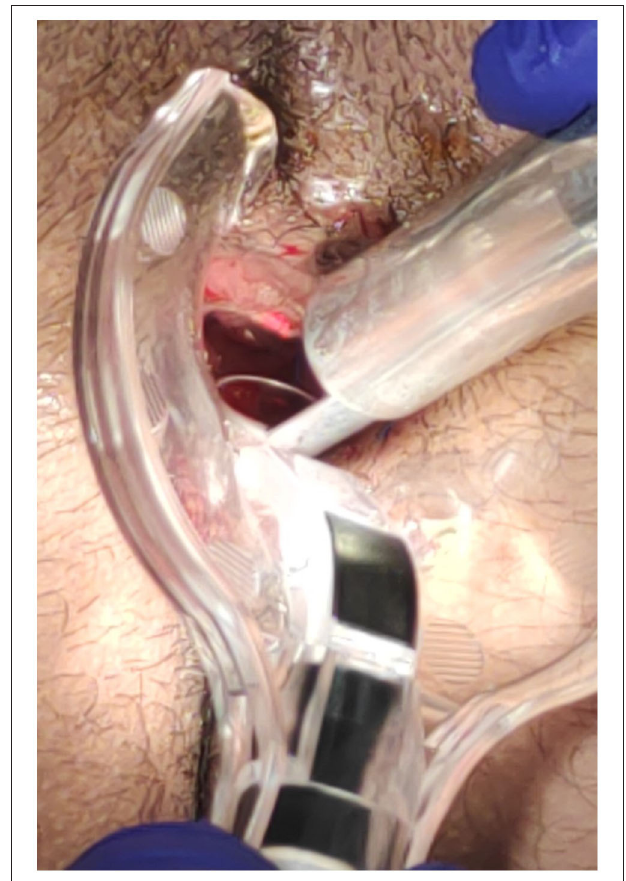
FIGURE 3 | Anterior fissure: fissure CO 2 laser scanner superficial vaporisation and